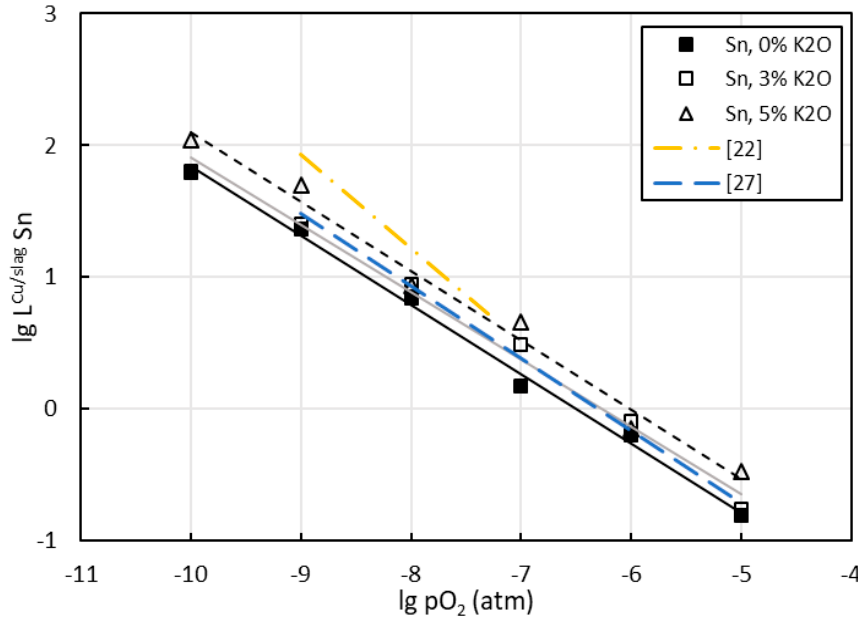
Figure 7. Distribution coefficient of tin between copper alloy and different slags as a function of oxygen partial pressure. For the concentrations in slags, LA-ICP-MS results were used below 10 − 8 atm pO 2 .